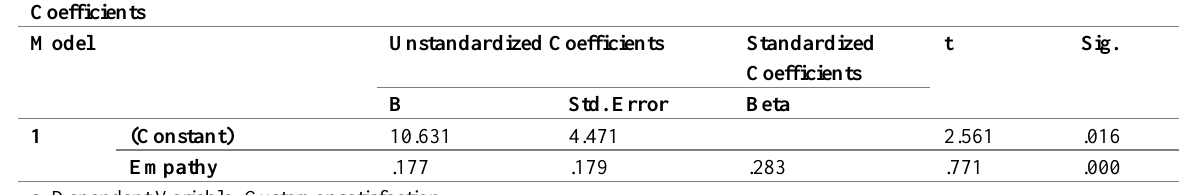
Table 15: Hypothesis Test Relationship between Empathy and Customer Satisfaction